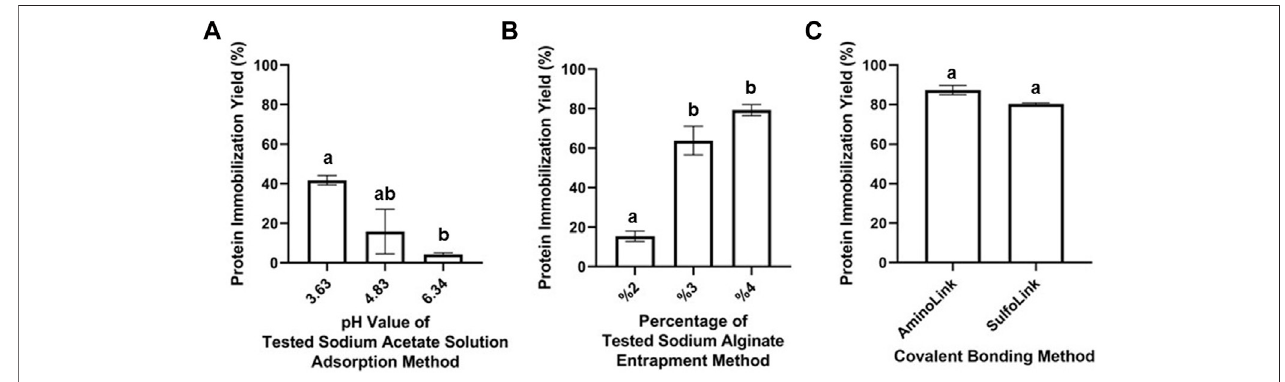
FIGURE 3 | Protein immobilization yield for adsorption- (A) , entrapment- (B) , AminoLink- (C) , and SulfoLink-based (C) immobilization methods, measured fl uorometrically by the Qubit Protein Assay Kit. Error bars represent standard deviation and mean values within the same graph, when followed by different letters (a,b, ab), they are signi fi cantly different at p < 0.05.